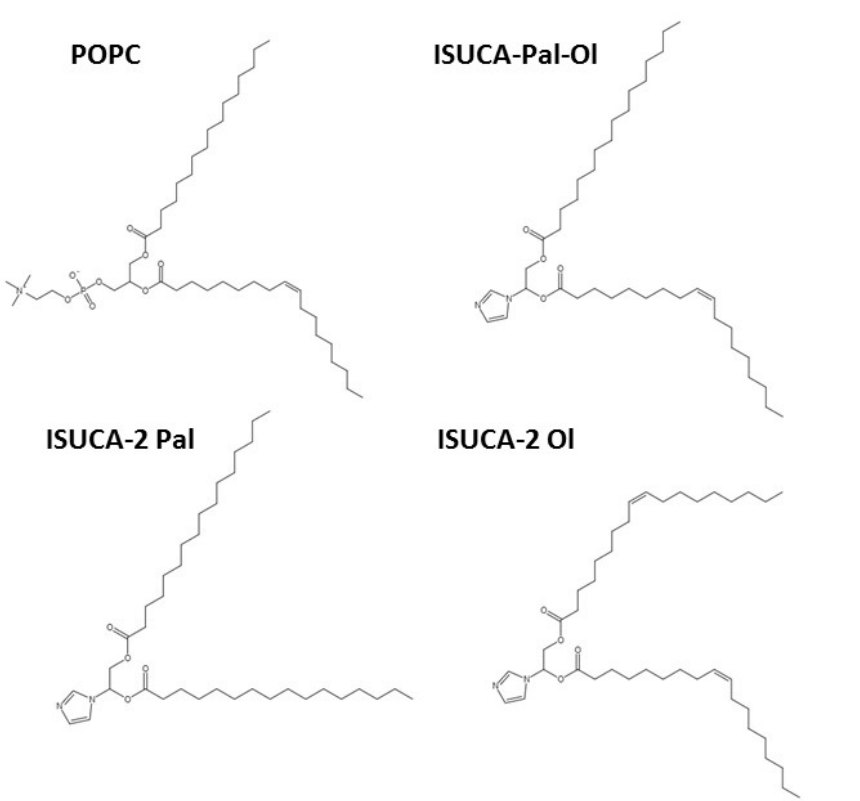
Figure 11. Chemical structures of POPC and ISUCA-derived lipids used in the construction of the lipid bilayers. lipid bilayers.